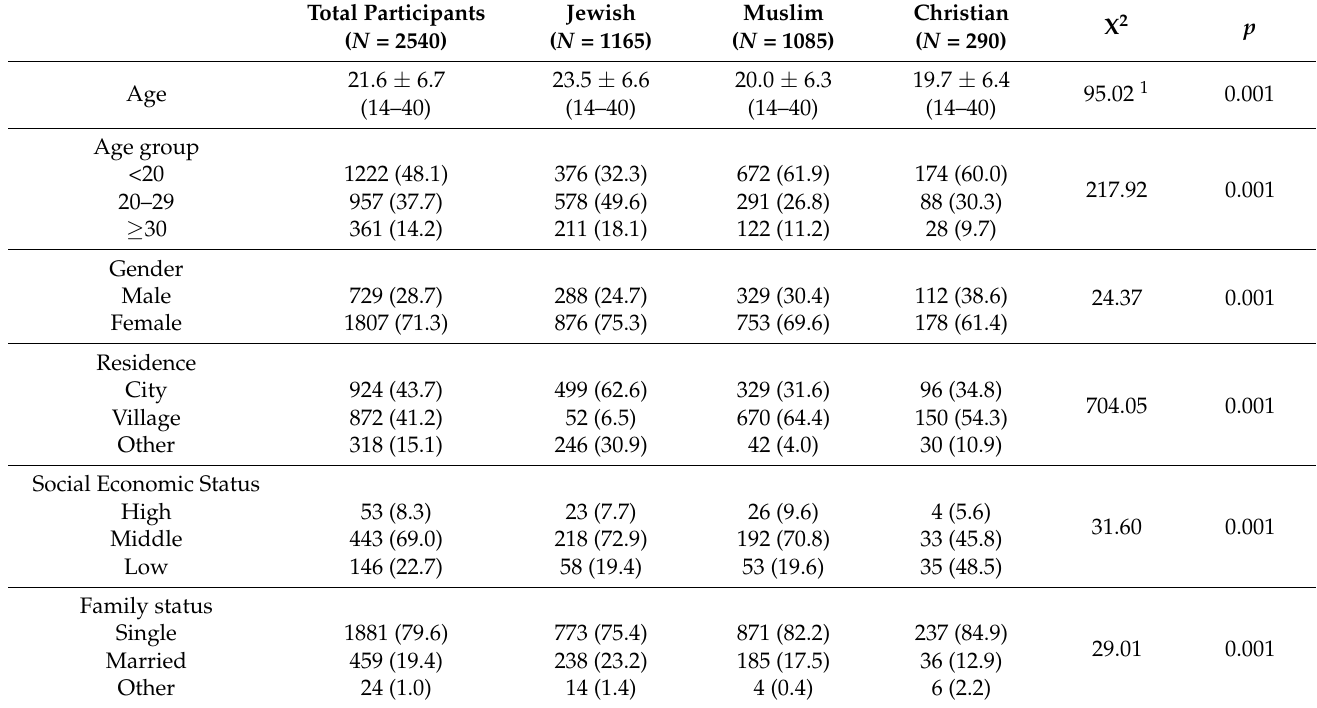
Table 1. Statistical differences of backgrounds among three groups: Jews, Arab Muslims, and Arab